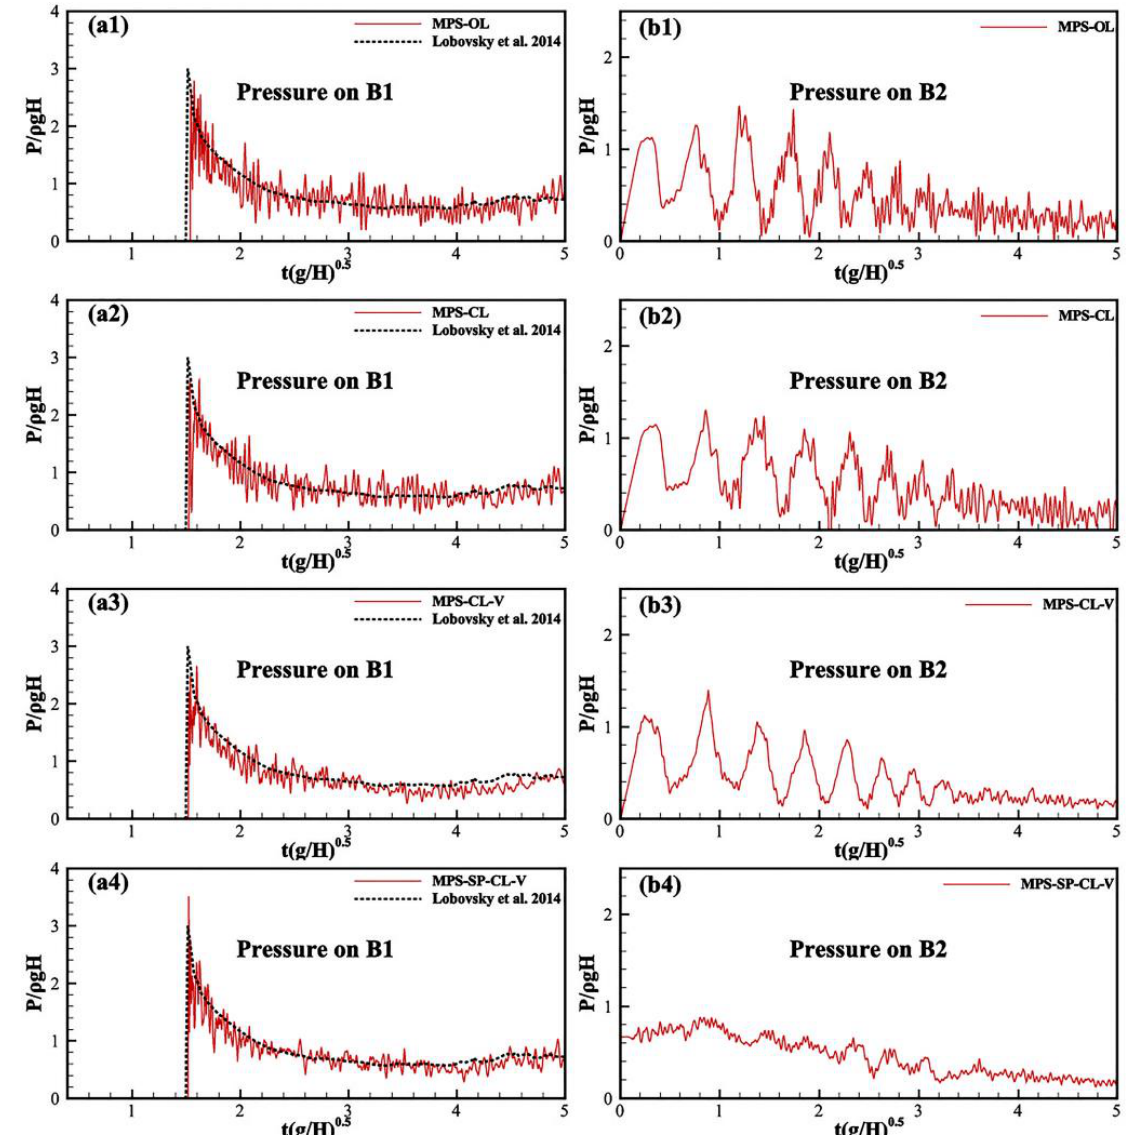
Figure 14. Time histories of pressure acting on B1 and B2 calculated by the models. ( a1 ) Pressure on B1 calculated by MPS-OL; ( a2 ) Pressure on B1 calculated by MPS-CL; ( a3 ) Pressure on B1 calculated by MPS-CL-V; ( a4 ) Pressure on B1 calculated by MPS-SP-CL-V; ( b1 ) Pressure on B2 calculated by MPS-OL; ( b2 ) Pressure on B2 calculated by MPS-CL; ( b3 ) Pressure on B2 calculated by MPS-CL-V; ( b4 ) Pressure on B2 calculated by MPS-SP-CL-V. The experiment curve of the pressure on point B1 is from Lobovsk ý et al.